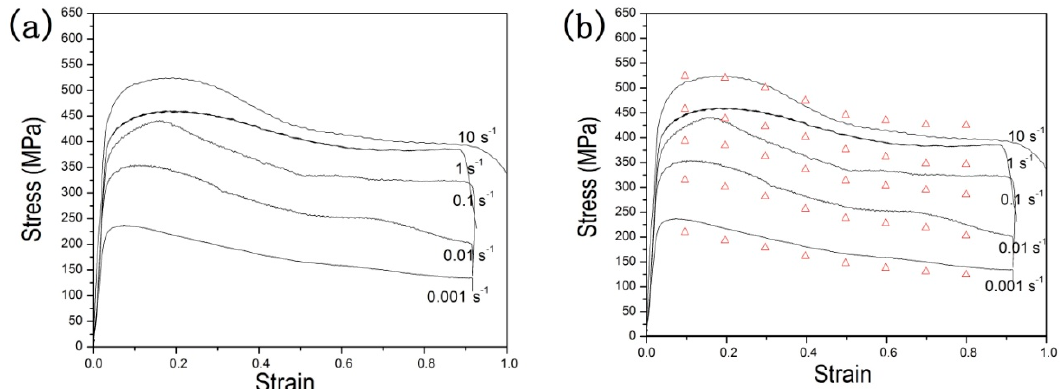
Figure 11. The comparison between the prediction and experimental results at temperature of 1023 K: ( a ) experimental results and ( b ) prediction results of different strain rates.